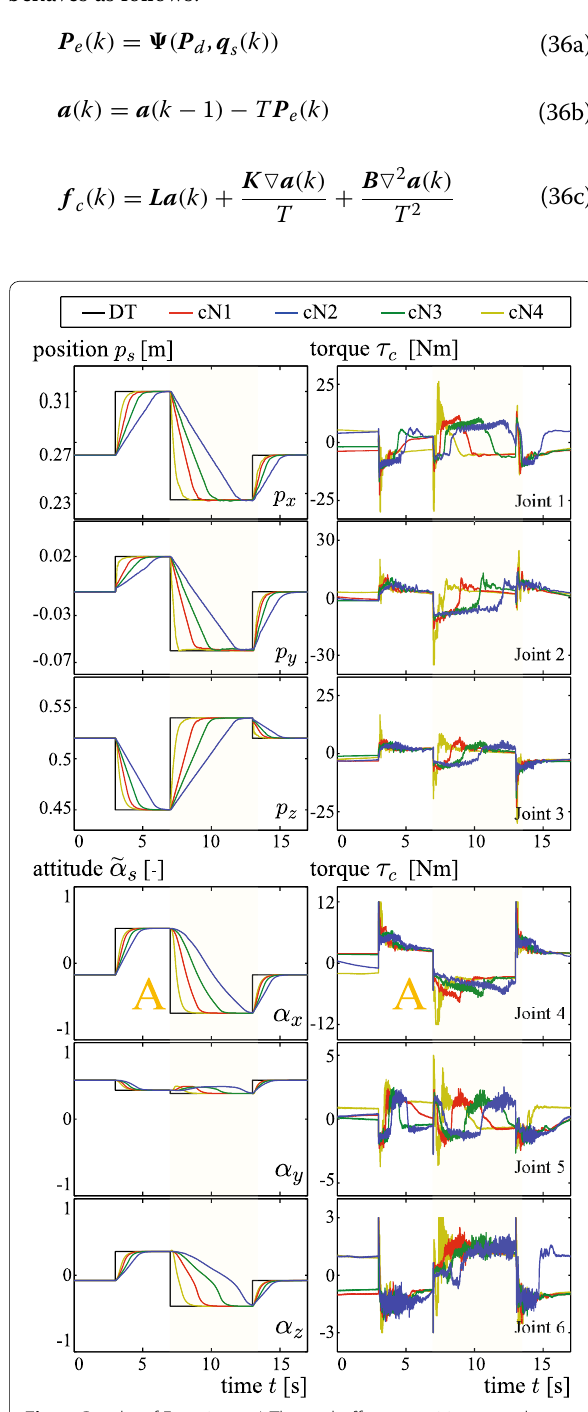
Fig. 5 Results of Experiment I. The end-effector position p s and attitude ˜ α s and each joint torque during set-point controllers under cN1 , cN2 , cN3 and cN4 where DT is desired trajectories, which are pointed in Fig.